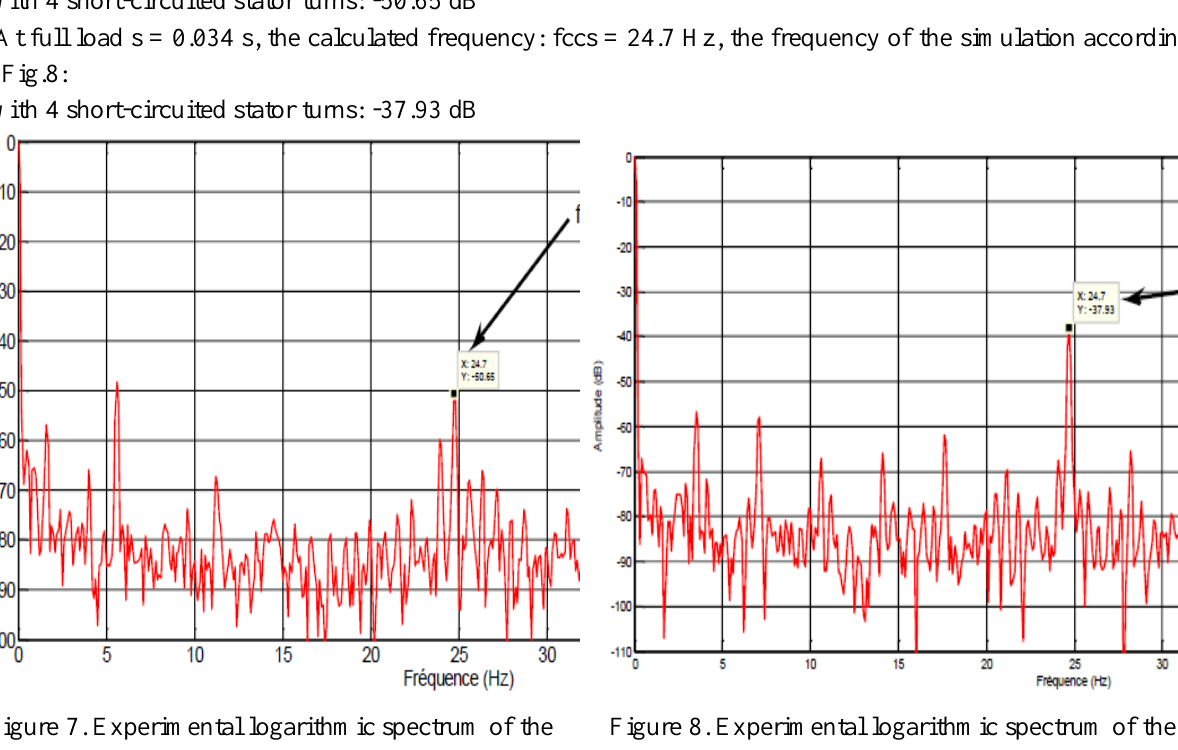
Figure 6. Experimental logarithmic spectrum of PVPA of a motor with 4 short-circuited stator turns at full load